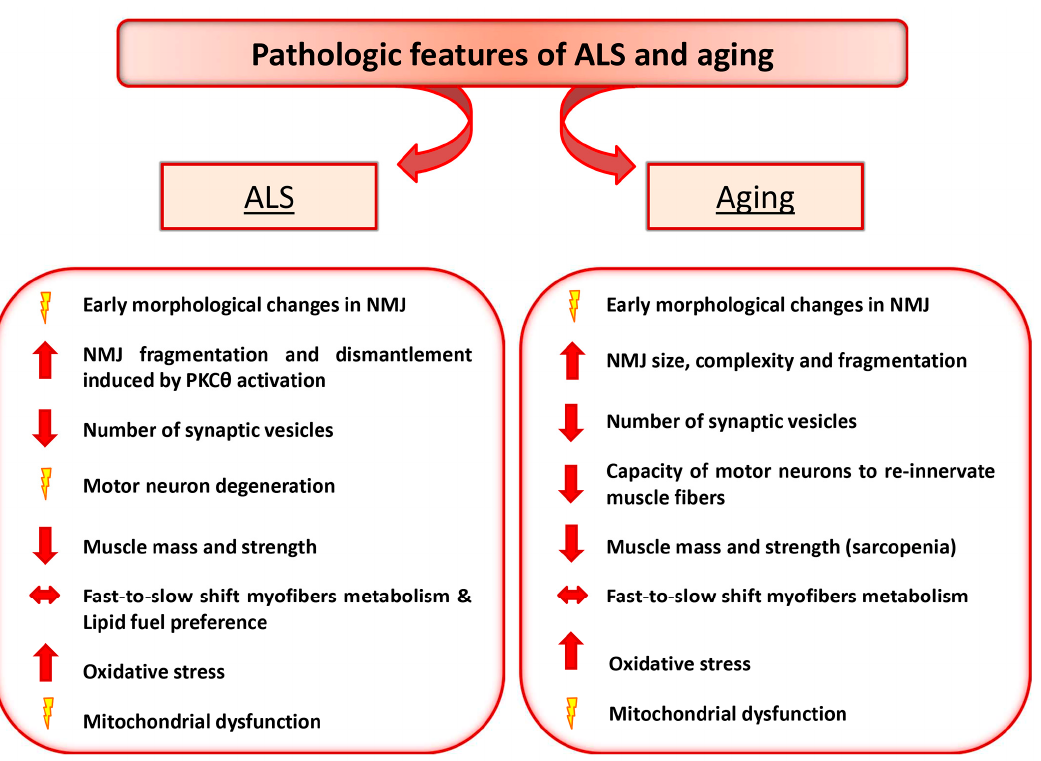
Figure 1. Amyotrophic Lateral Sclerosis (ALS) and Aging share some common pathologic features. The diagram depicts the relevant pathologic changes observed in ALS and aging.